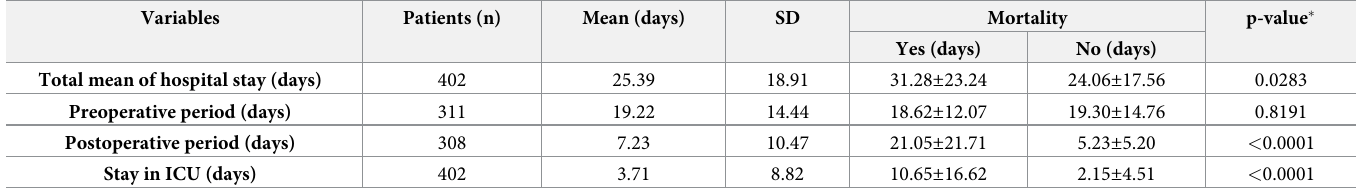
Table 4. Total mean of hospital stay, preoperative period, postoperative period and days in ICU when comparing the surviving and mortality groups.